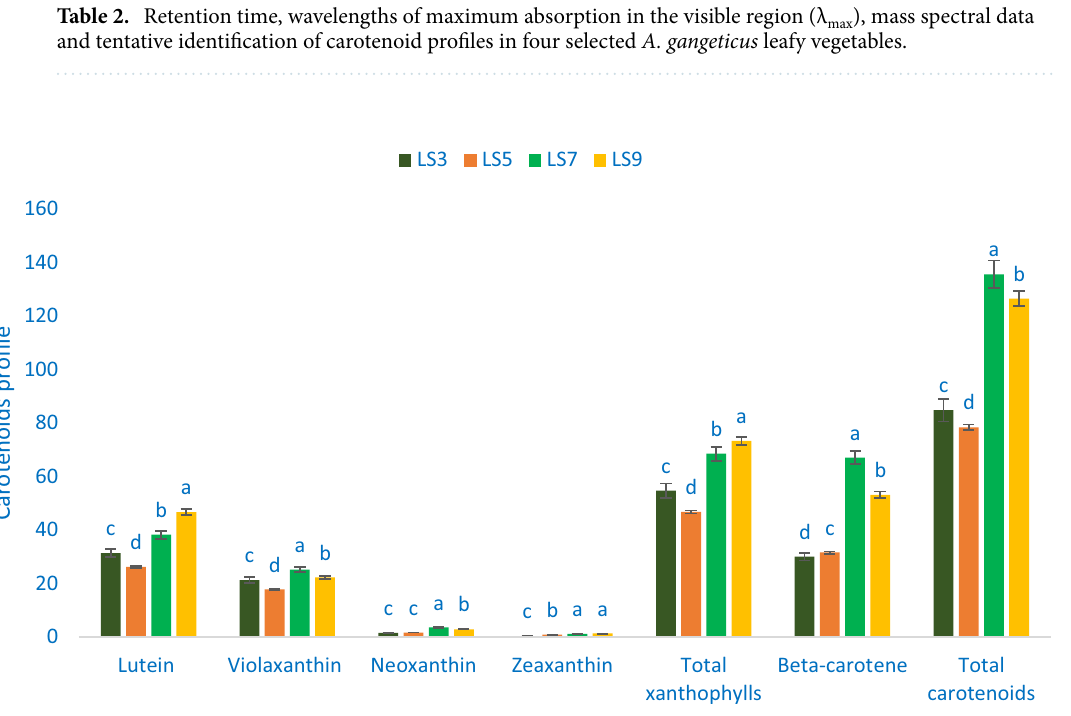
Figure 3. Carotenoid profiles (mg 100 g −1 FW) in four selected A. gangeticus leafy vegetables, different letters in the bar are differed significantly by Duncan Multiple Range Test ((P < 0.01), (n =